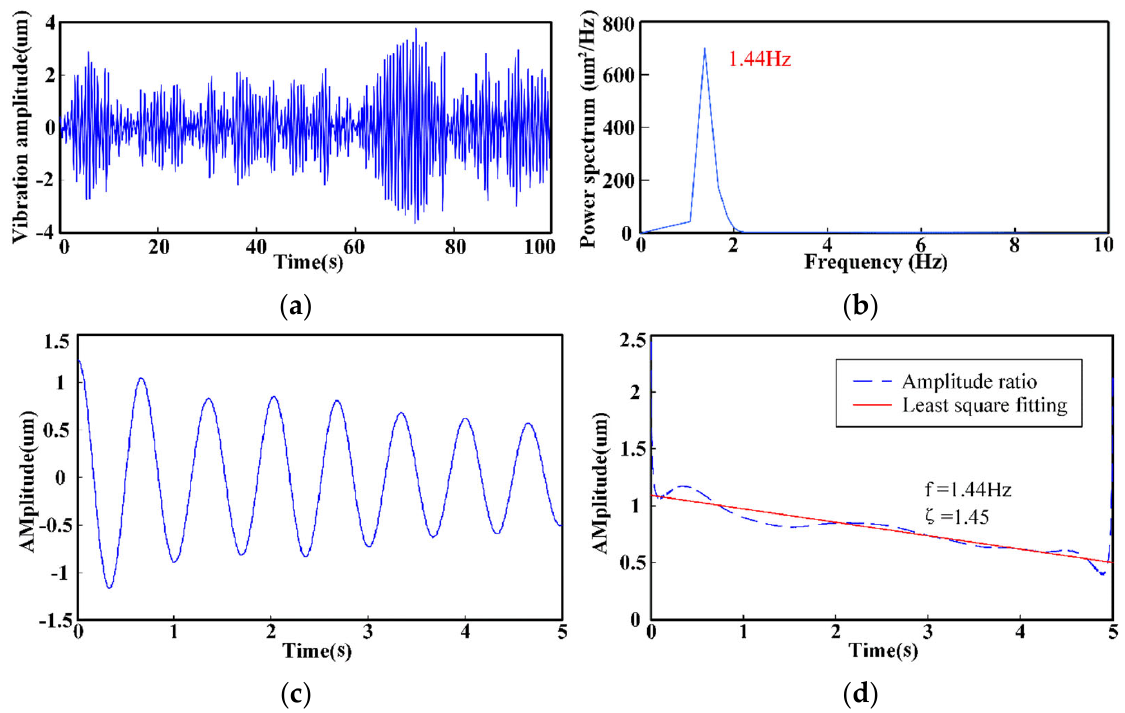
Figure 11. Process of modal parameters identification of Y1 component. ( a ) Time history; ( b ) Power spectra; ( c ) Free attenuation response; ( d ) Logarithmic amplitude curve.